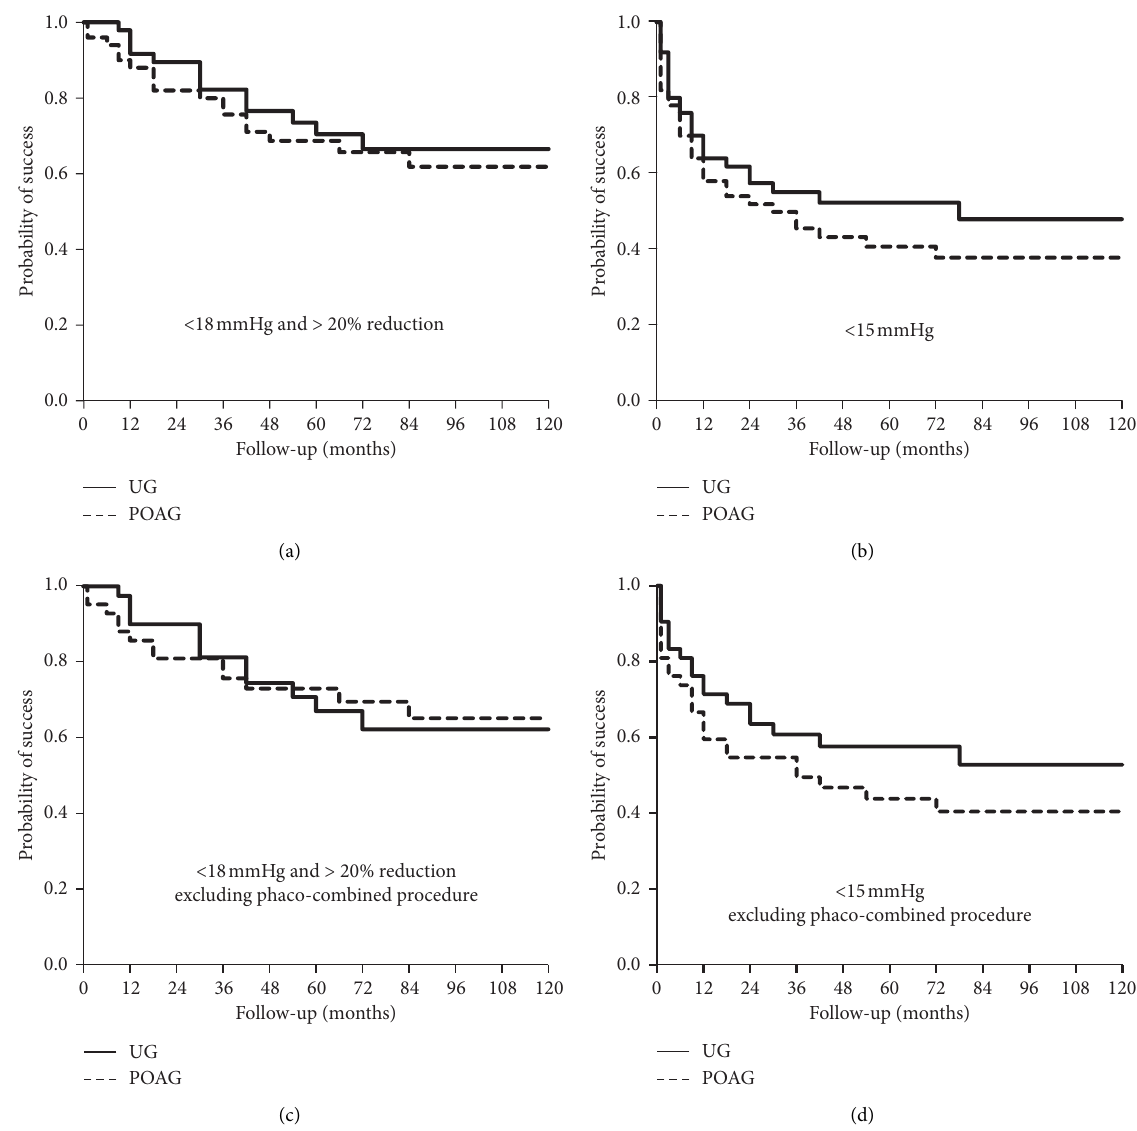
Figure 2: Kaplan–Meier survival curves for the success criteria comparing UG and POAG. (a) and (b) contain all 100 eyes. (c) and (d) show the results excluding phaco-combined procedure (84 eyes). Criterion: (a) and (c), IOP < 18mmHg and > 20% reduction from baseline; (b) and (d), IOP < 15mmHg. There was no significant difference between UG and POAG in each criterion ( P � 0 . 57, 0.33, 0.99, and 0.26,